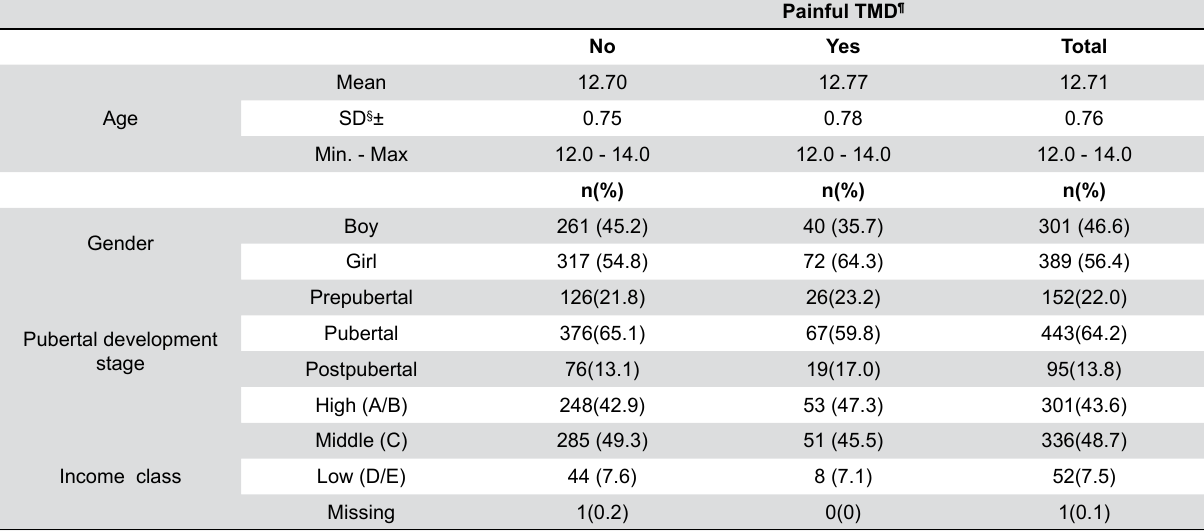
Table 1- Descriptive statistics of the predictor variables stratified by the presence of painful TMD